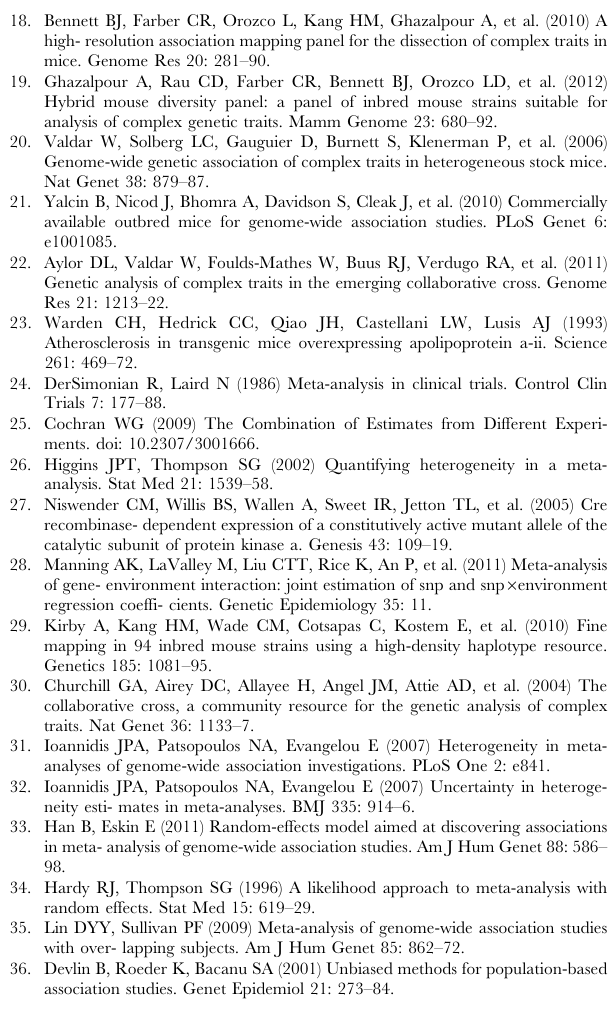
Figure S19 Forest plot and PM-plot for Chr9:101972687 locus. Figure S20 Forest plot and PM-plot for Chr10:21399819 locus. Figure S21 Forest plot and PM-plot for Chr10:90146088 locus. Figure S22 Forest plot and PM-plot for Chr11:69906552 locus. Figure S23 Forest plot and PM-plot for Chr11:114083173 locus. Figure S24 Forest plot and PM-plot for Chr14:33632464 locus. Figure S25 Forest plot and PM-plot for Chr15:21194226 locus. Figure S26 Forest plot and PM-plot for Chr15:59860191 locus. Figure S27 Forest plot and PM-plot for Chr17:46530712 locus. Figure S28 Forest plot and PM-plot for Chr18:82240606 locus.